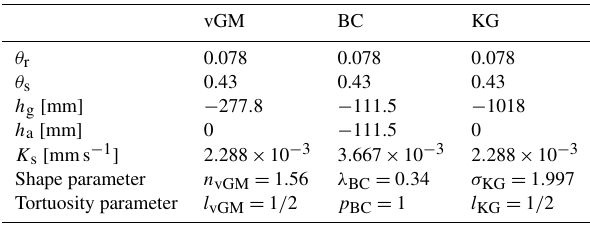
Table 2. Hydraulic parameters, i.e., values of the residual and satu- rated water contents, θ r and θ s ; the scale parameter for water pres- sure head h g ; the air-entry water pressure head h a ; the saturated hy- draulic conductivity K s ; and the shape parameters involved in the hydraulic models used for the description of the water retention and the hydraulic conductivity curves, i.e., Eqs. (26), (28), and (29). vGM BC KG θ r 0.078 0.078 0.078 θ s 0.43 0.43 0.43 h g [ mm ] − 277 . 8 − 111 . 5 − 1018 h a [ mm ] 0 − 111 . 5 0 K s [ mms − 1 ] 2 . 288 × 10 − 3 3 . 667 × 10 − 3 2 . 288 × 10 − 3 Shape parameter n vGM = 1 . 56 λ BC = 0 . 34 σ KG = 1 . 997 Tortuosity parameter l vGM = 1 / 2 p BC = 1 l KG = 1 /